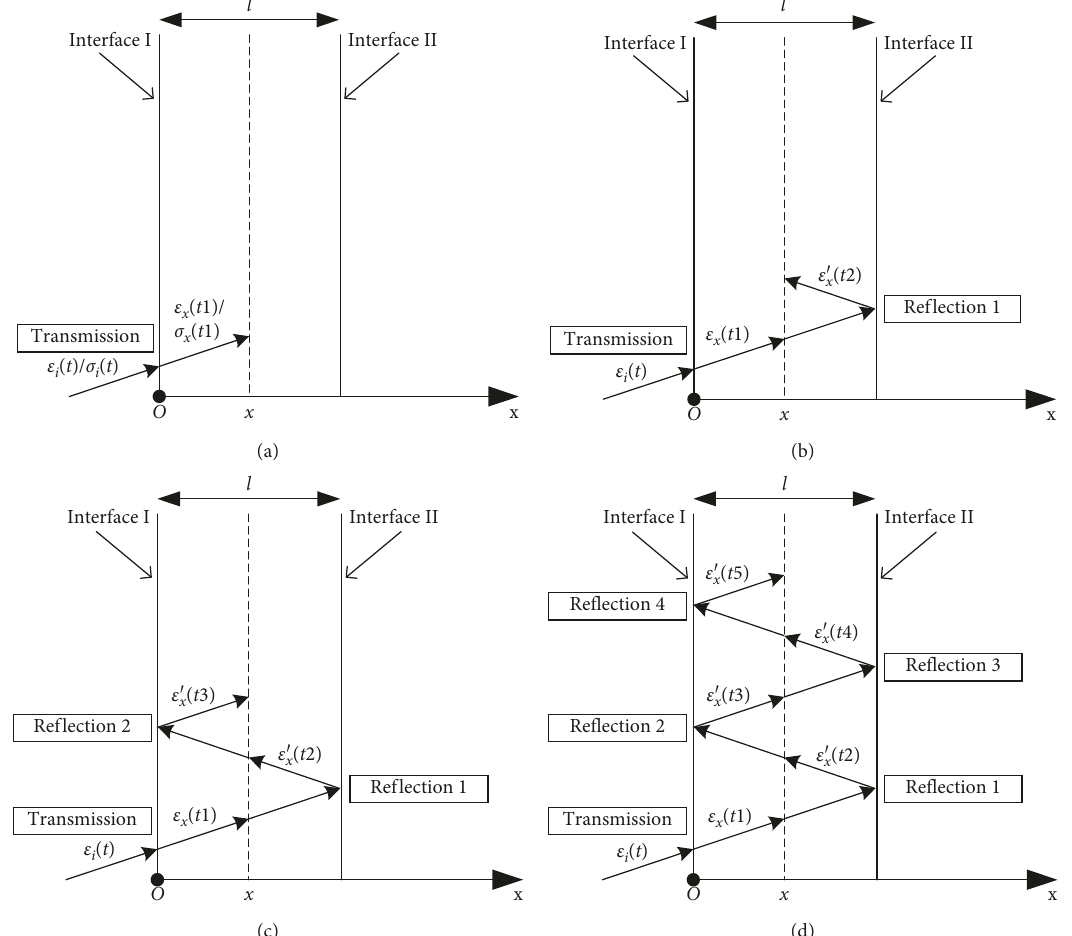
Figure 7: Transfer process of stress wave in the tested specimen. (a) Initial transmission. (b) First reflection. (c) Second reflection. (d) Fourth